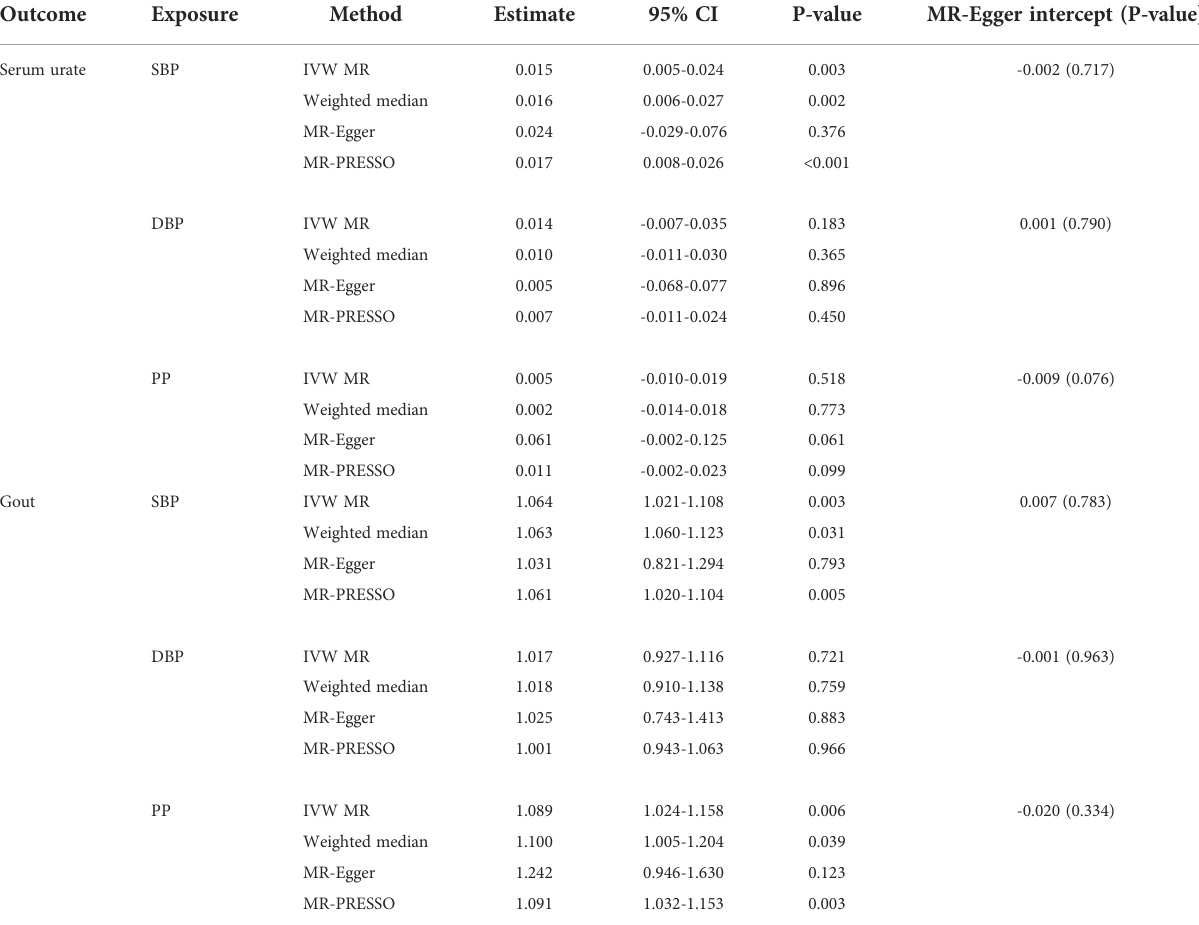
TABLE 5 Mendelian randomization estimates of blood pressure on serum urate or gout. Outcome